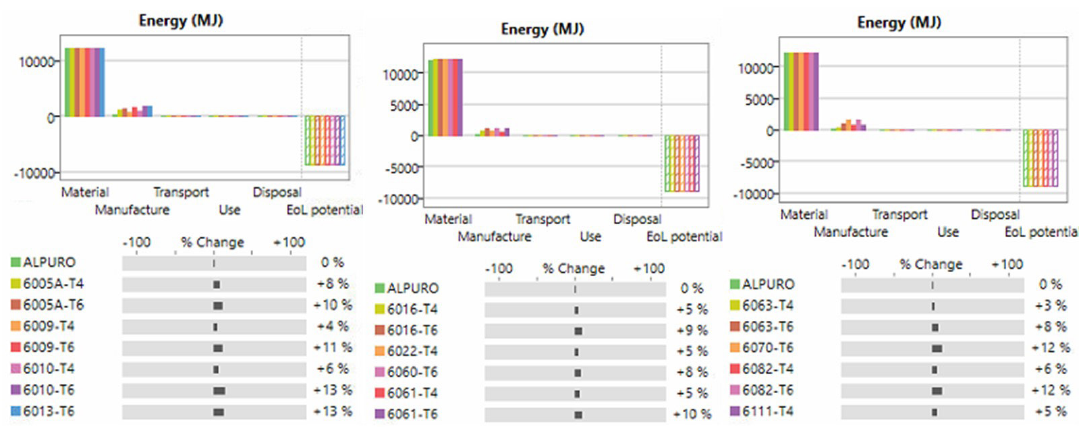
Figure 7. Energy consumption in the production and manufacturing of the 6000 series alloys. Images used are courtesy of ANSYS, Inc.